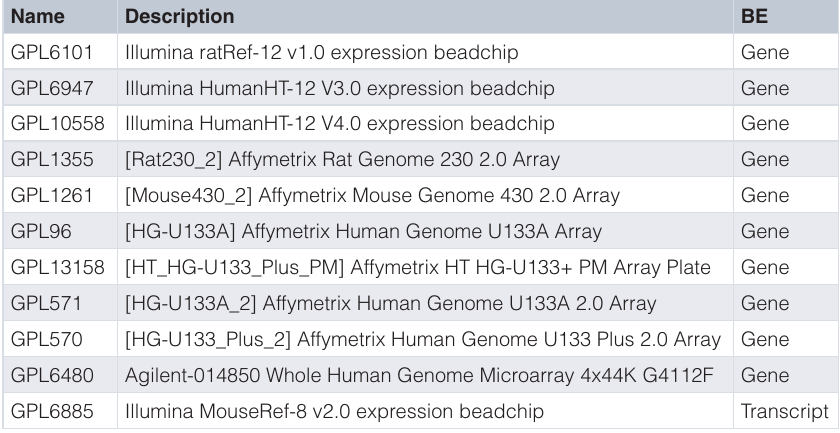
Table 2. Genomics platforms available in the BED UCB-Human database